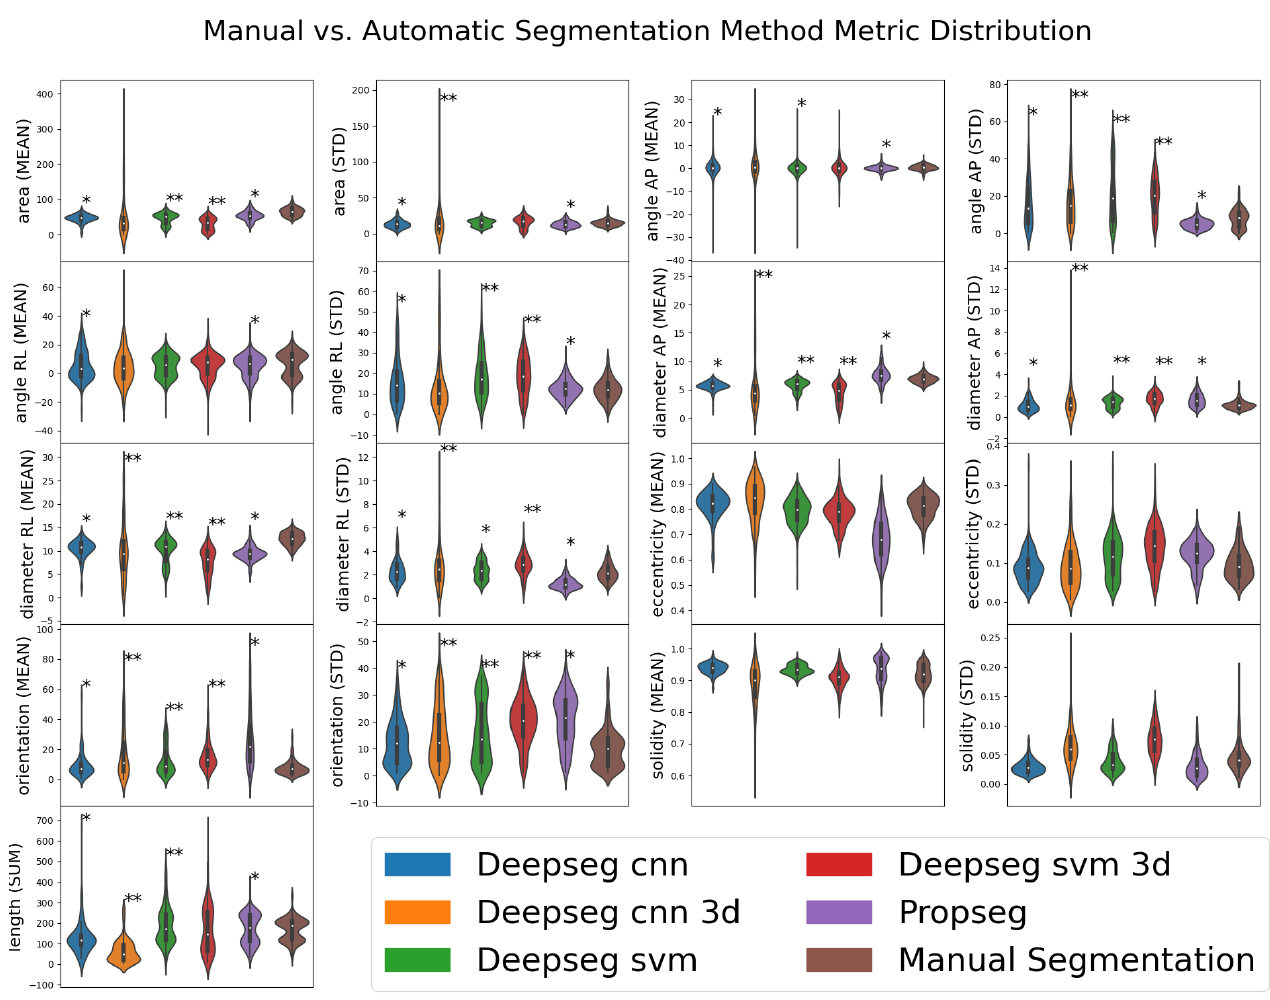
Figure 4. Visualized distributions of various metrics estimated by various segmentation methods for a subset of 50 patient records. Manual segmentation results are shown as the far-right distribution for each metric. Automated segmentation methods (not “Manual Segmentation”) are denoted with asterisks denoting how significantly different their distribution is from that of the “Manual Segmentation” distribution; ** for p < 0.01, * for p < 0.05, as evaluated by one-way ANOVA using SciPy’s f_oneway function (selected for its ease of implementation). Metrics taken from automated SCT analysis [13] of segmentations from 195 spinal cord MRI